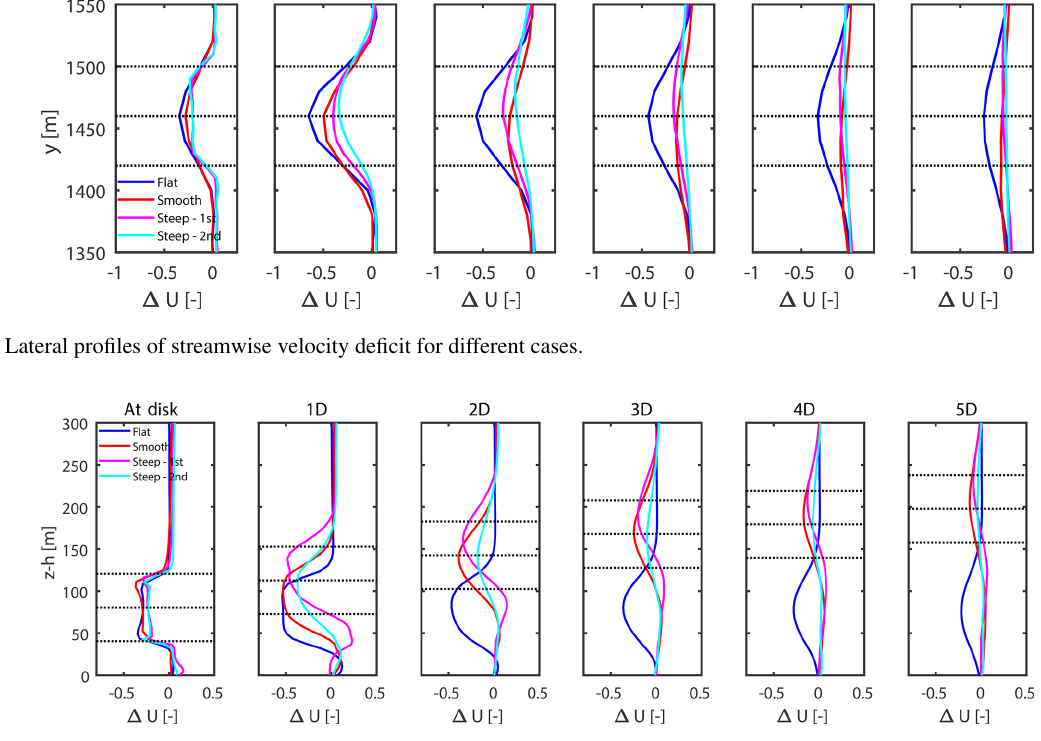
Figure 10. Vertical profiles of streamwise velocity deficit for different